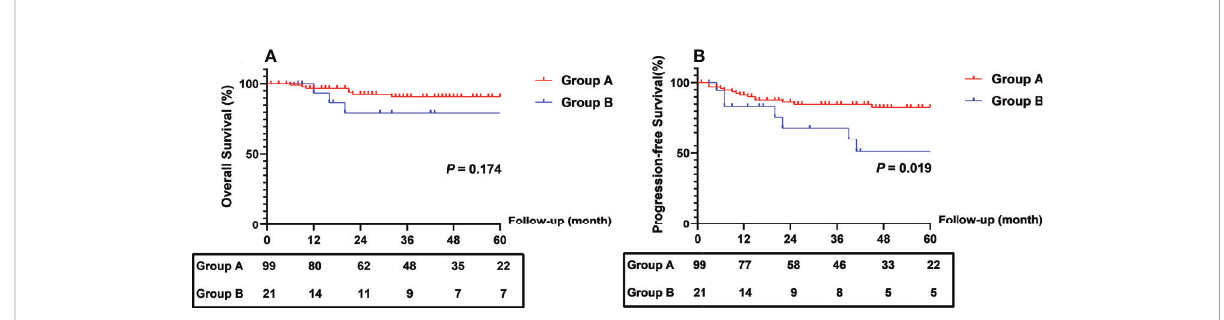
FIGURE 4 Comparison of survival outcomes between patients with different different CEA clearance pattern. CEA, carcinoembryonic